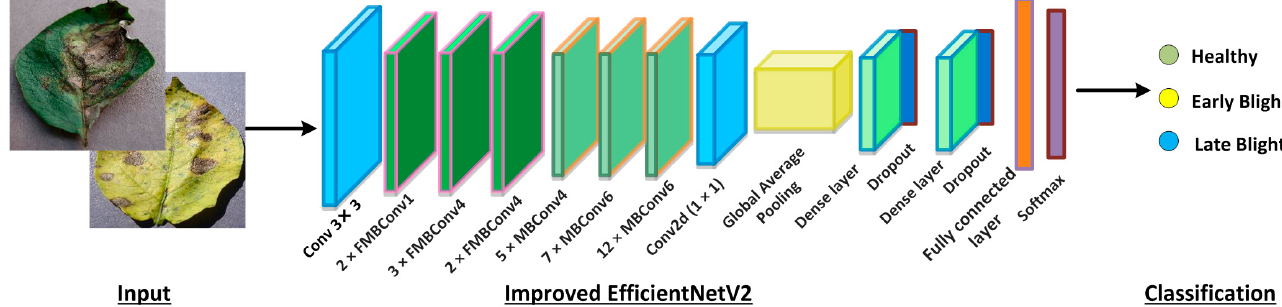
Figure 1. Flow of the proposed EfficientNetV2 framework. Algorithm1: Steps followed by EfficientPNet for potato plant leaf abnormality categorization